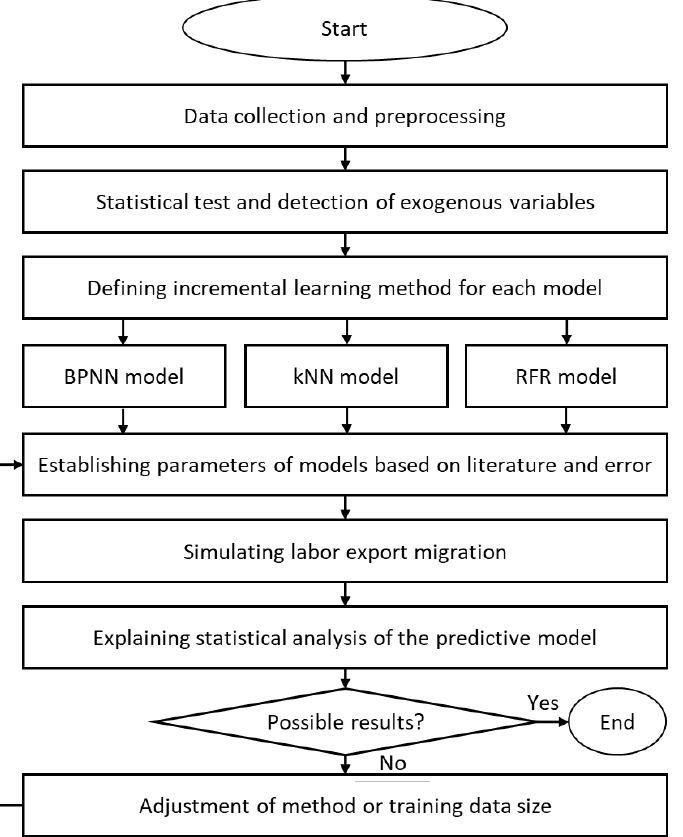
Figure 1. The process of the experimental stages in this study.